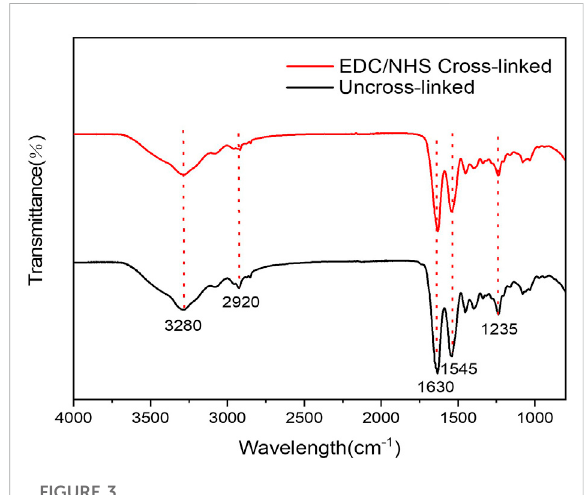
FIGURE 3 ATR-FTIR spectra of swimming bladders before and after